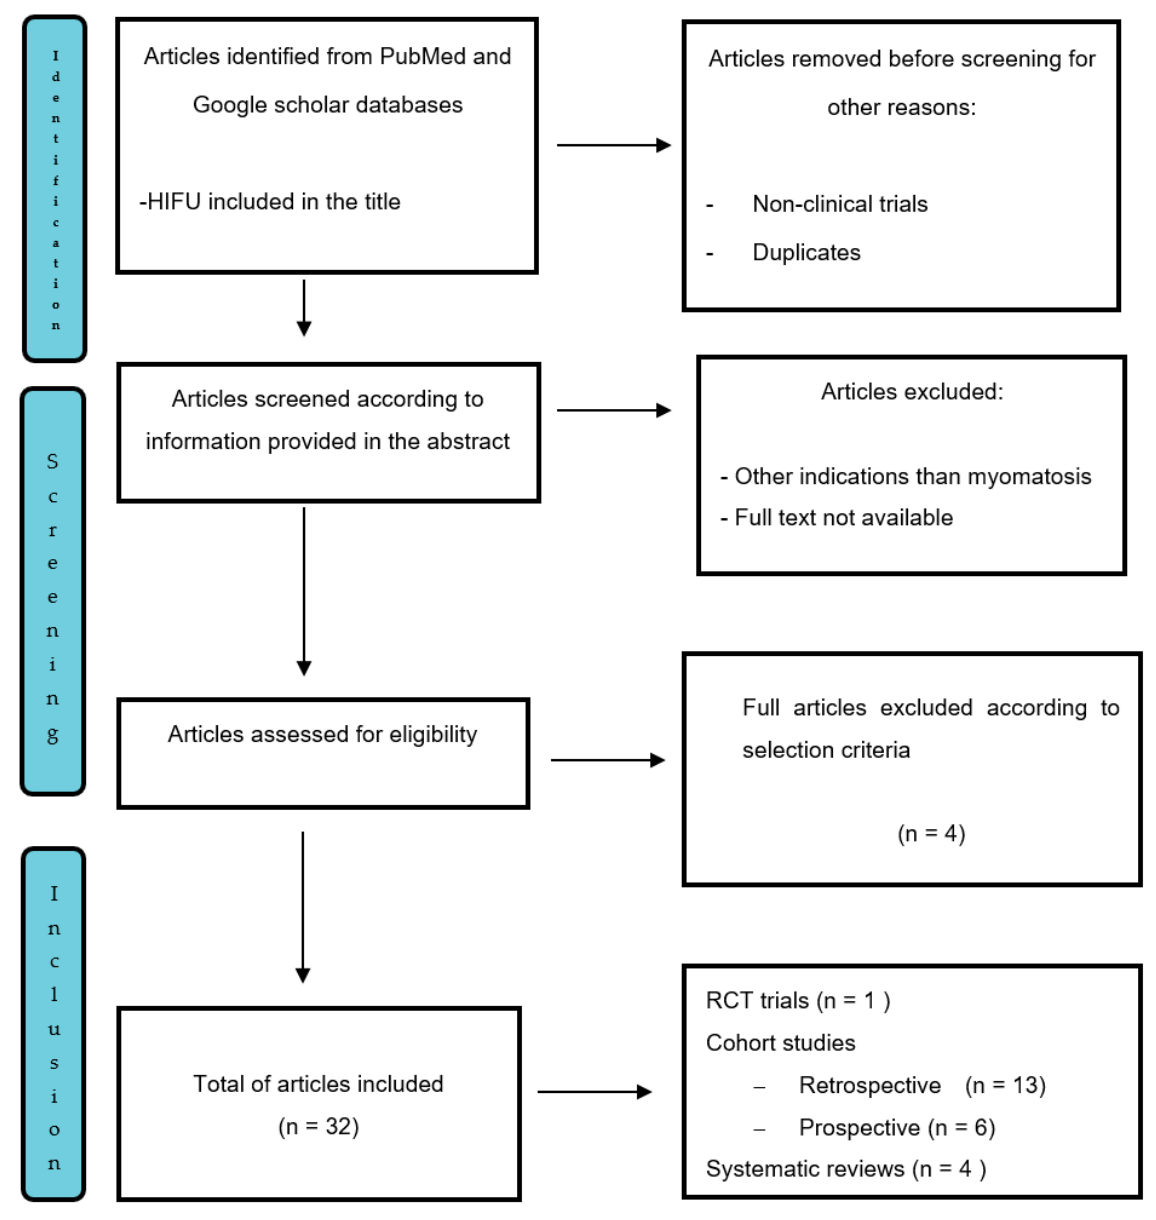
Figure 1. Prisma flow diagram showing the selection of articles regarding high frequency focused ultrasound (HIFU) for uterine fibroid treatment. Patient Characteristics